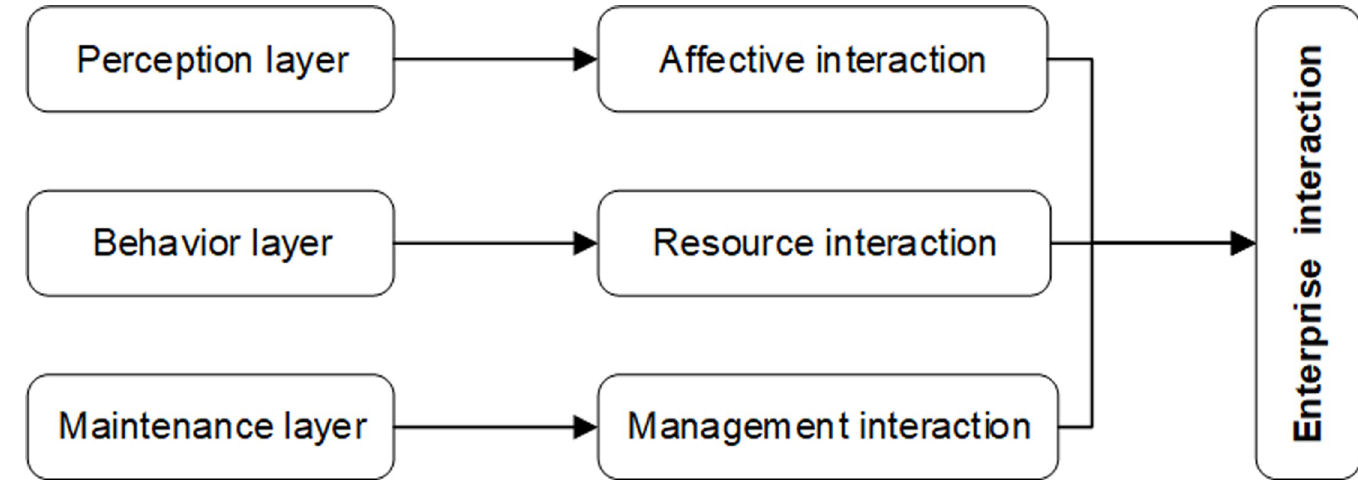
Fig 1. Dimensional analysis of enterprise